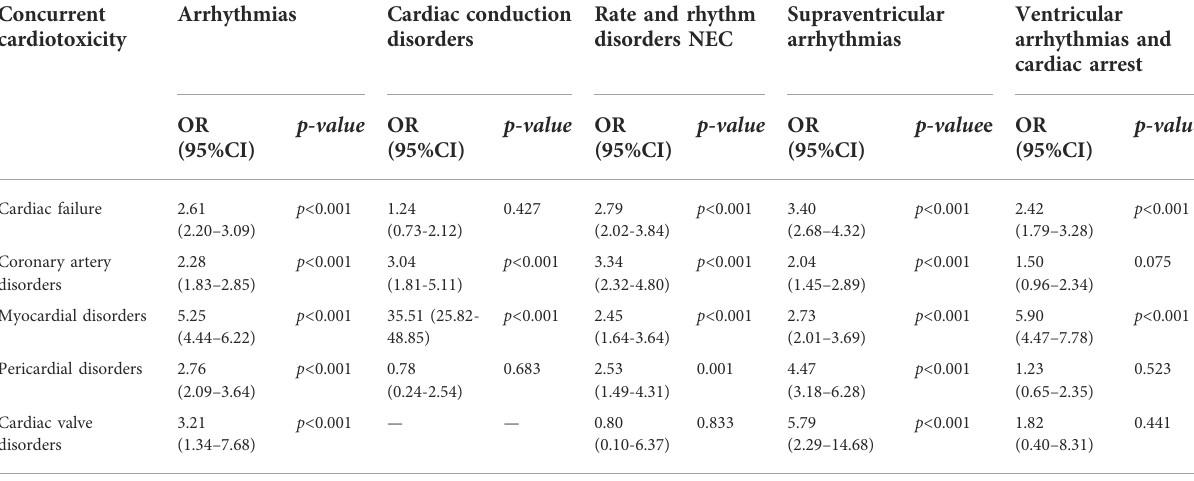
TABLE 5 The multivariate analysis of concurrent cardiotoxicity and ICI-associated